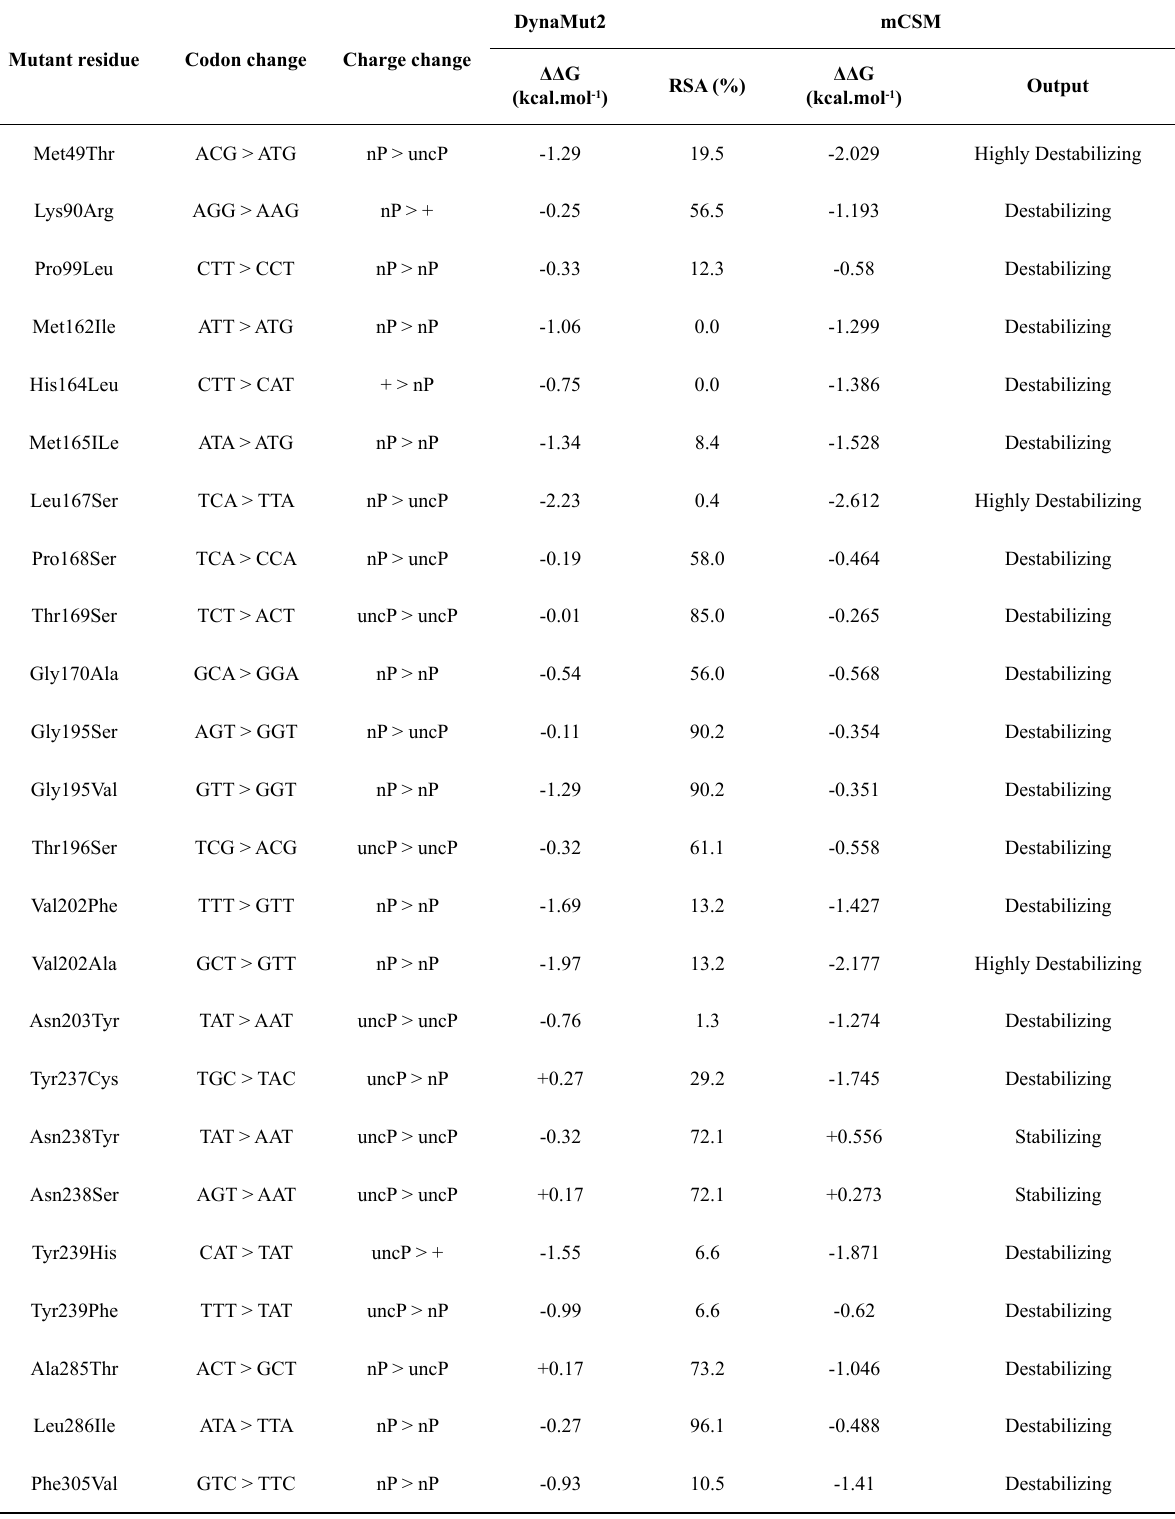
Table 1 - Changes in stability of 3CL pro of